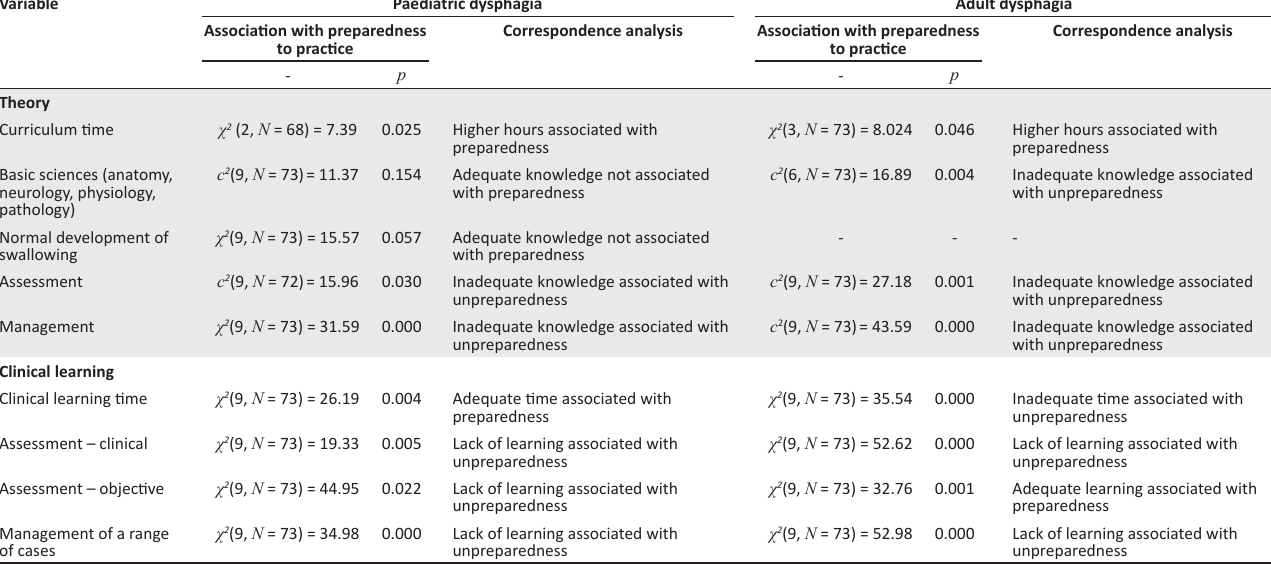
TABLE 3: Association between elements of the theory and clinical learning curricula and perceptions of preparedness for dysphagia practice.